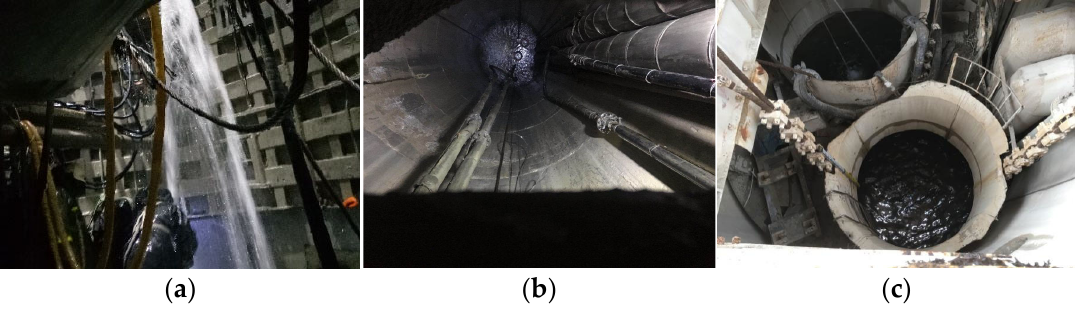
Figure 3. No. 1 vertical auxiliary shaft flooded. ( a ) Water inrush; ( b ) Gushing water; ( c ) Flooded shaft.